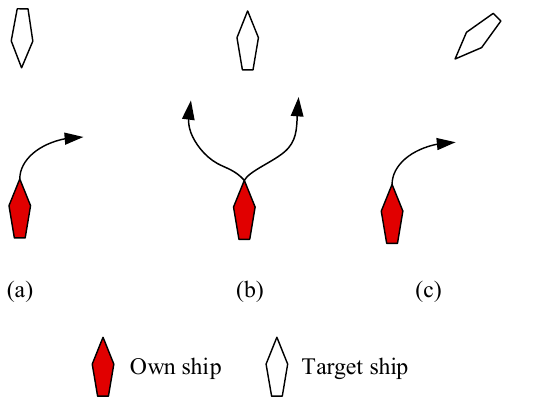
Figure 7. Ship collision avoidance direction in each situation. (a) Head-on. (b) Overtaking. (c) Crossing.